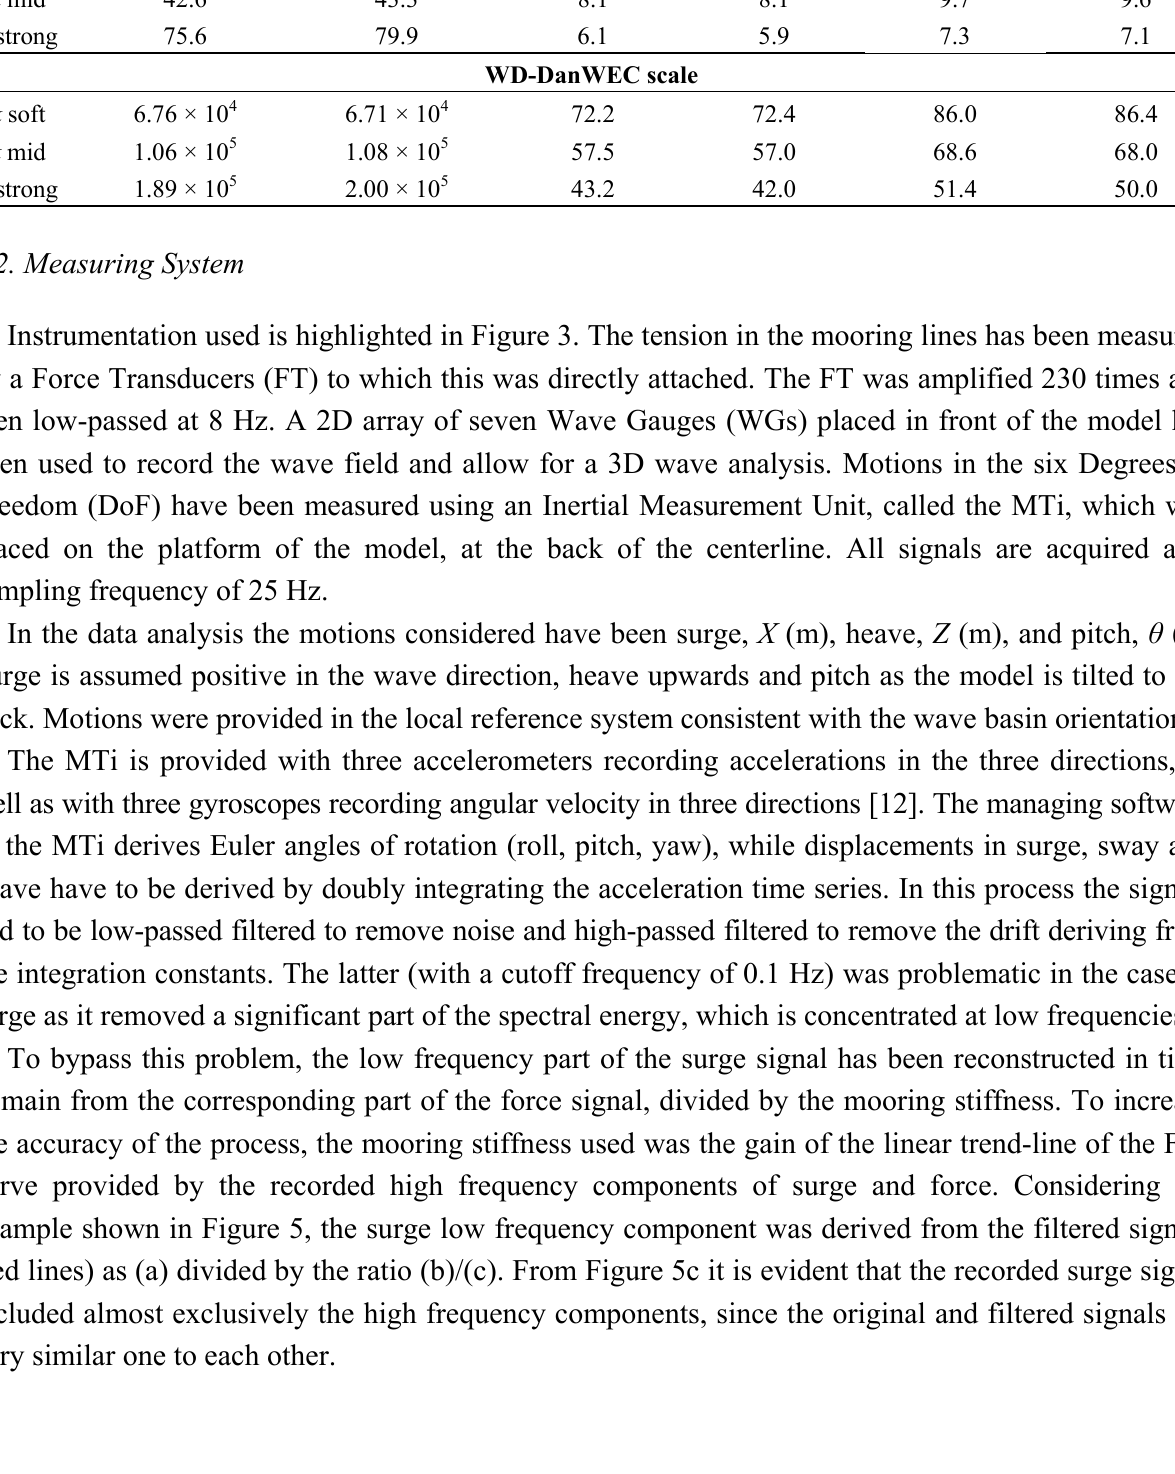
Table 3. Features of the spring used to model the main mooring line, for which target and actual values are reported. k (N/m) is the spring stiffness, T Target k (N/m) Actual k (N/m)